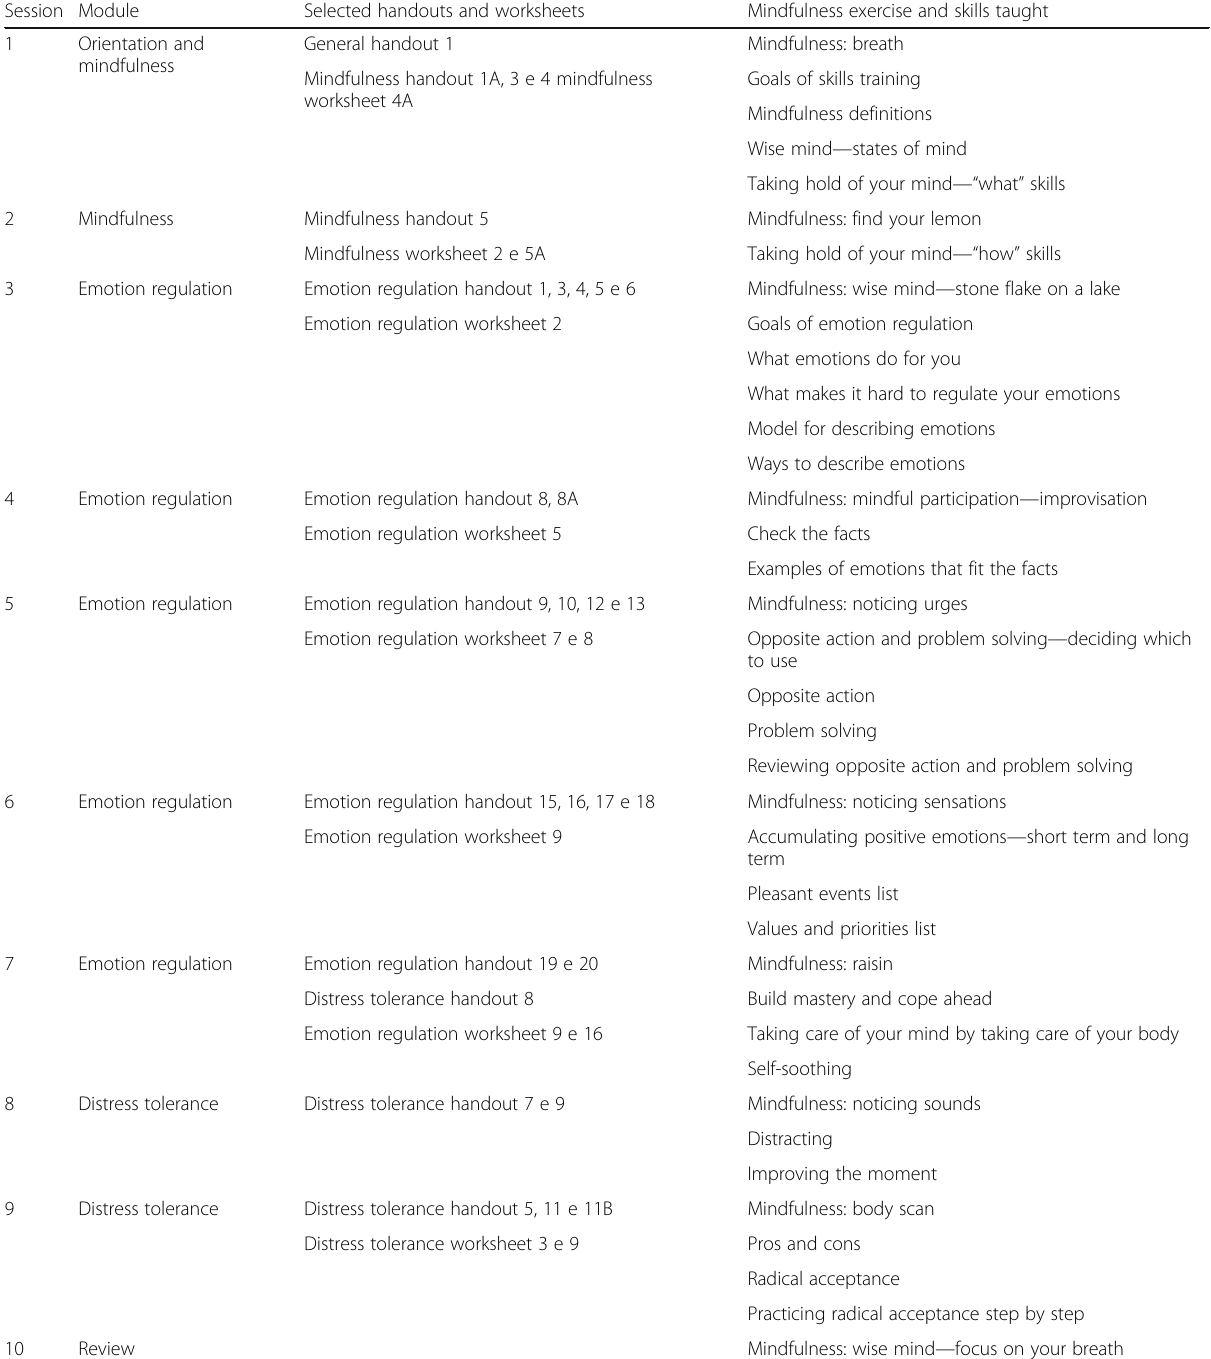
Table 2 Adapted DBT skills training intervention (as shown in Cancian et al. 2017) Session Module Selected handouts and worksheets Orientation and